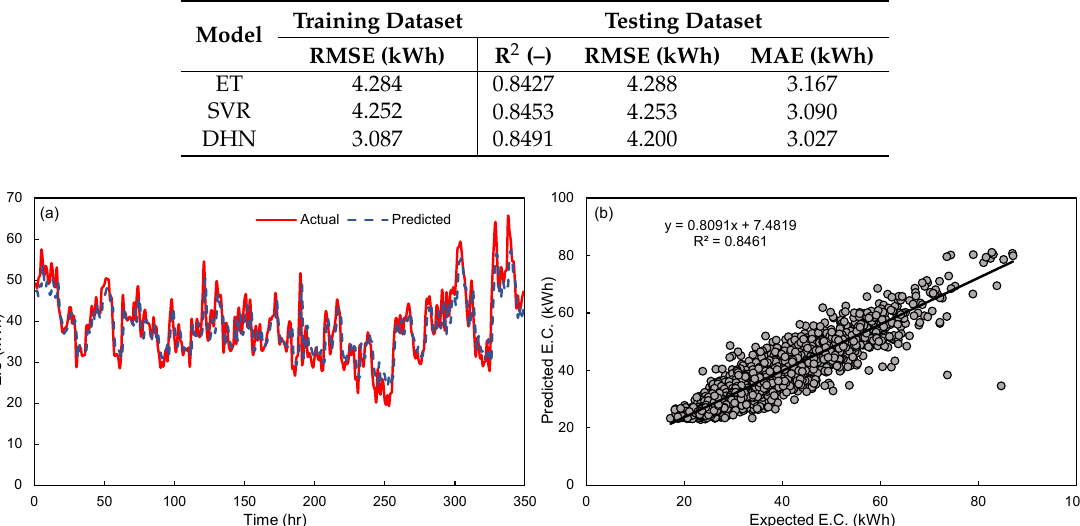
Figure 4. Results from extremely randomized trees model. ( a ) comparison between actual and predicted energy consumption from the extremely randomized trees (ET) model; ( b ) scatter chart illustrating the relationship between predicted and actual energy